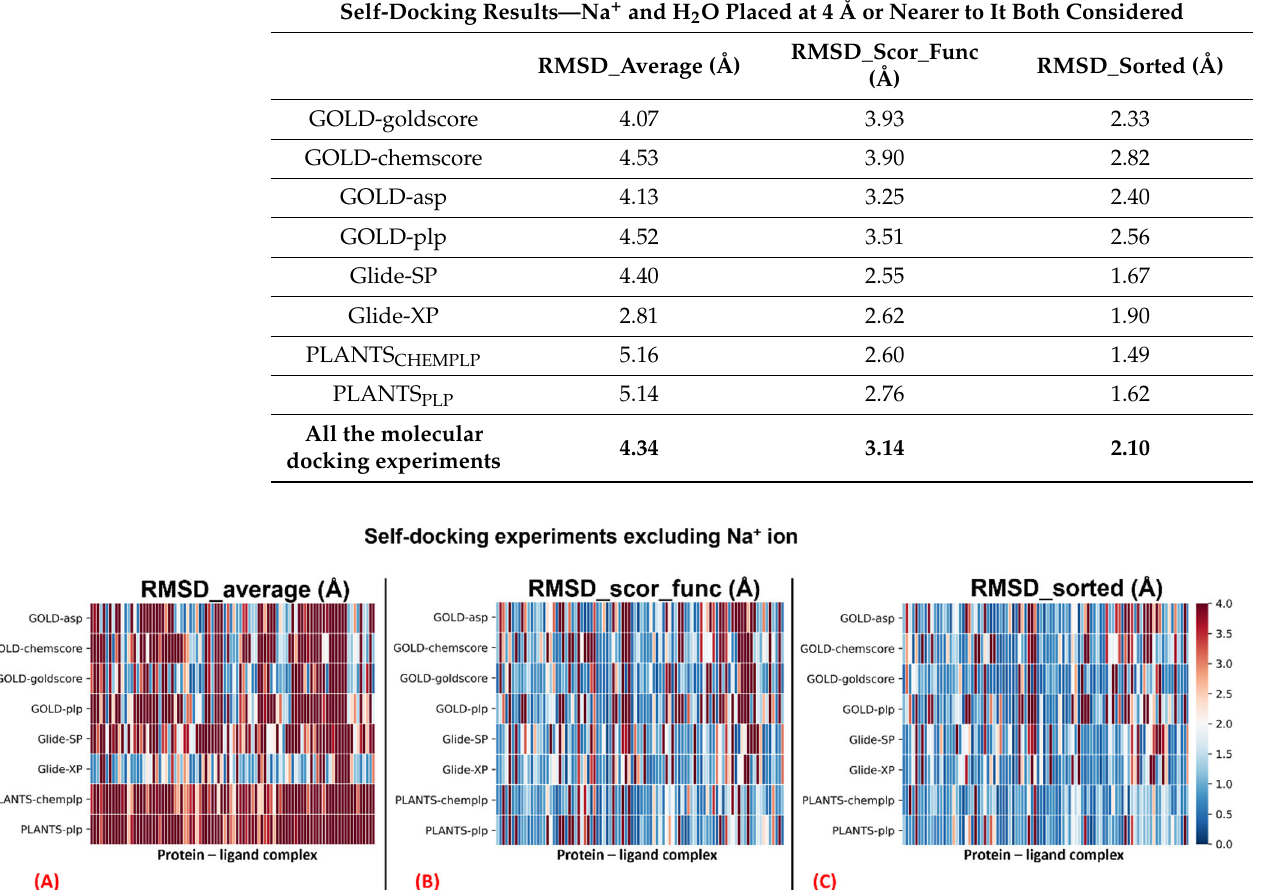
Table 2. Table showing the results of the self-docking calculations executed considering the sodium ionand the water molecules surrounding it.